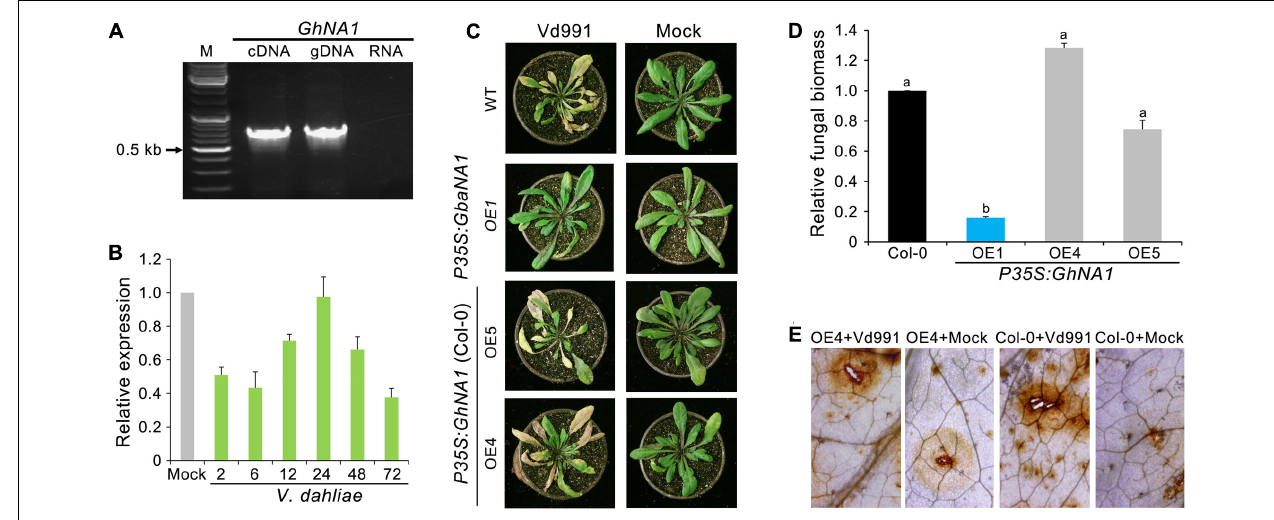
FIGURE 6 | The GbaNA1 homolog from G. hirsutum does not enhance Verticillium resistance in Arabidopsis thaliana . (A) Cloning GhNA1 from the Verticillium wilt susceptible G. hirsutum cv. Junmian No. 1. GhNA1 was cloned by reverse transcription-PCR using the cDNA template and genomic DNA, respectively. DNA contamination in the RNA sample was assayed by PCR (RNA lane). (B) Expression analysis of GhaNA1 in G. hirsutum cv. Junmian No. 1 after inoculation with V. dahliae Vd991. Three-week-old cotton seedlings were root-dipped (2 × 10 6 conidia/mL) collected over a time-course and RNA was extracted from roots. The relative expression levels of GhNA1 were assessed by quantitative reverse transcriptase PCR, using the A. thaliana UBQ1 gene as a reference. Plants treated with sterile water were used as controls (Mock). Error bars represent standard errors of three biological replicates. (C) Verticillium wilt symptoms of GhNA1 transgenic A. thaliana inoculated with V. dahliae . Two independent transgenic lines of 3-week-old Col-0 seedlings were inoculated with V. dahliae (strain Vd991) via root-dipping in a suspension of 5 × 10 6 conidia/mL. The GbaNA1 transgenic line (OE1) and wide type (Col-0) served as positive and negative controls, respectively. Mock inoculations were performed with sterile water. (D) Quantification of V. dahliae biomass in GhNA1 transgenic A. thaliana plants (OE4, OE5, and OE6) compared to the wild type (Col 0). Fungal biomass was determined by quantitative real-time PCR using genomic DNA extracted from whole plants 21 days after inoculation. Error bars represent standard errors of three biological replicates. Columns with different letters indicate statistical significance ( P < 0.01), according to unpaired Student’s t -tests. (E) Detecting the ROS-inducing activities of GhNA1 transgenic A. thaliana . Leaves from 3-week-old plants were visualized 12 h after infiltration with 50 µ L V. dahliae , strain Vd991 (5 × 10 6 conidia/mL). Sterile water treatment served as a control (Mock). Leaves were stained with